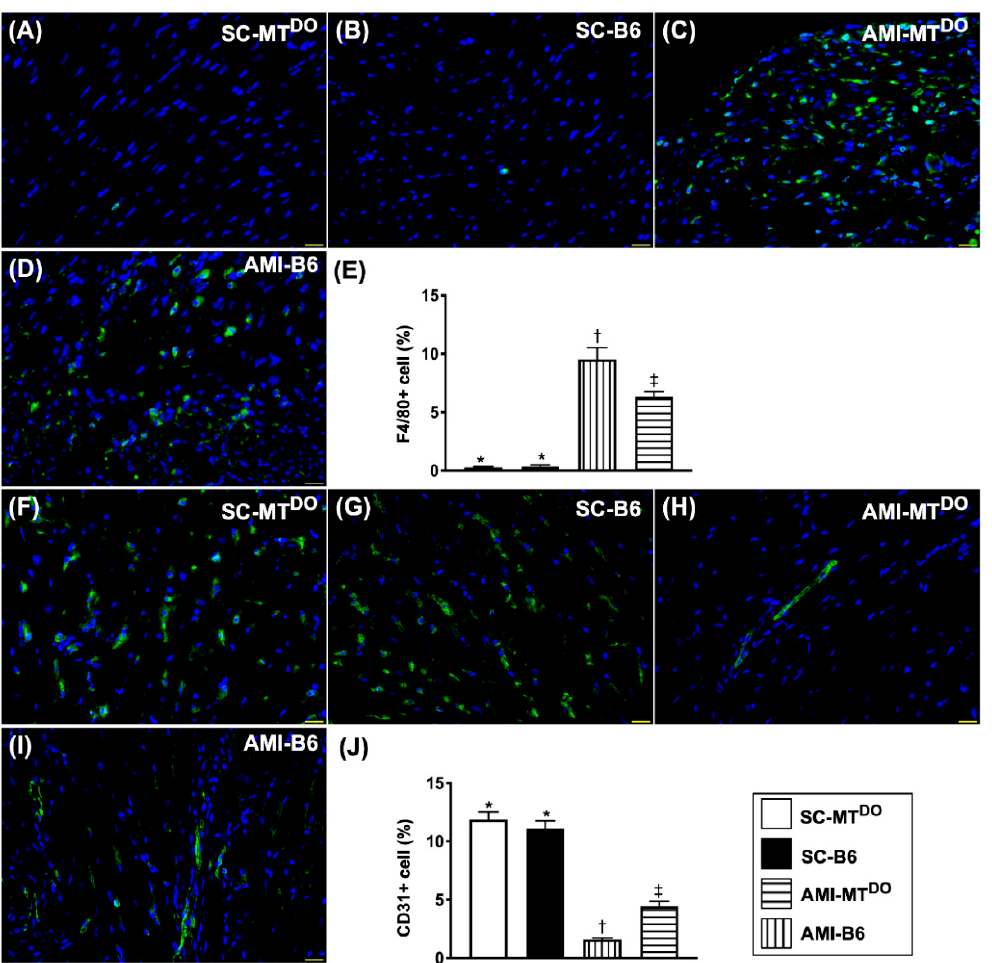
Figure 8. Inflammatory cell infiltration and endothelial cell distribution in the LV myocardium by 60 days after the AMI procedure. ( A–D ) The immunofluorescent (IF) microscopic findings (400 × ) for identification of F4 / 80 + cells (green color). ( E ) Analytical result of the number of F4 / 80 + cells, * vs. other groups with di ff erent symbols ( † , ‡ ), p < 0.0001. ( F–I) The IF microscopic findings (400 × ) for identification of CD31 + cells (green color). ( J ) Analytical result of the number of CD31 + cells, * vs. other groups with di ff erent symbols ( † , ‡ ), p < 0.0001. The scale bars in the right lower corner represent 20 µ m. All statistical analyses were performed by one-way ANOVA, followed by Bonferroni multiple comparison post hoc test ( n = 6 for each group). Symbols (*, † , ‡ ) indicate significance (at 0.05 level). SC = sham-operated control; MT DO = double knock out of matrix metalloproteinase (MMP)-9 and tissue plasminogen (tPA) in mouse; B6 (i.e., wild type) = C57BL / 6 mice. LV = left ventricular; AMI = acute myocardial infarction.